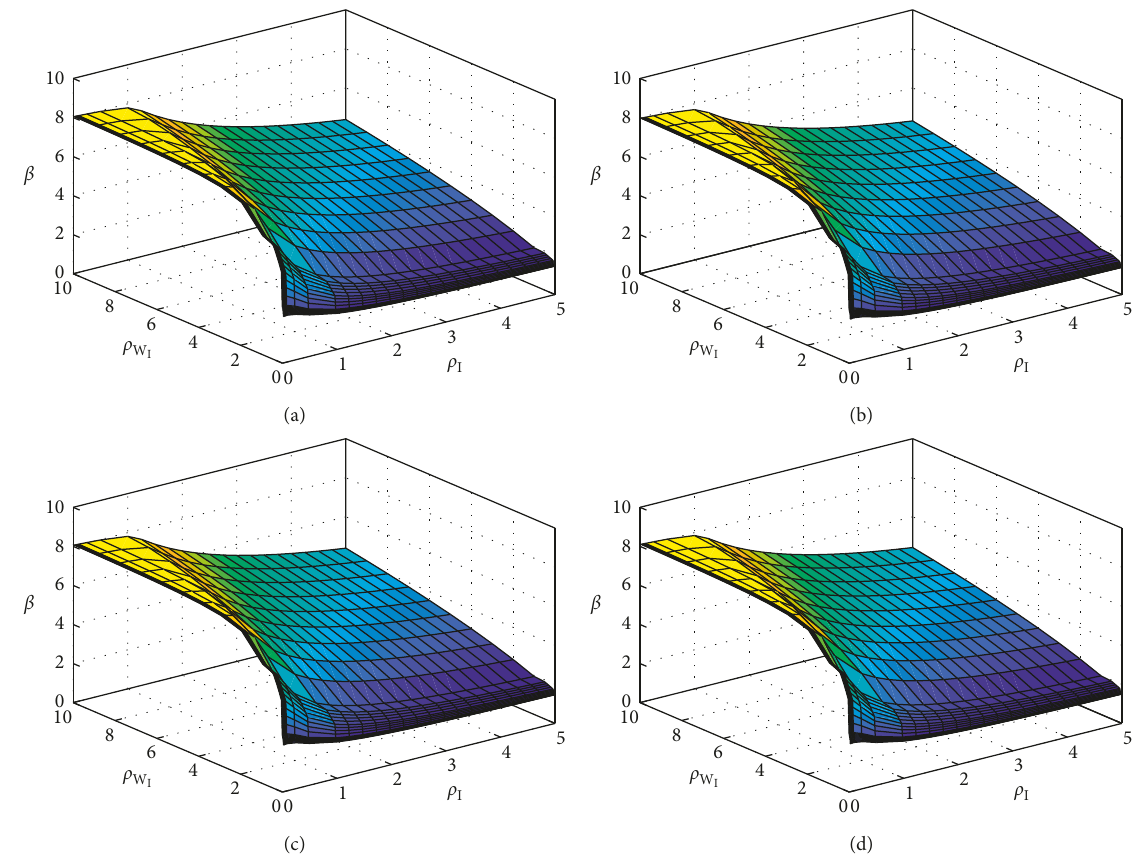
Figure 5: Reliability indices for stability calculation of axially loaded member. (a) Q235: d > 16 ∼ 40mm, (b) Q235: d > 40 ∼ 60 mm, (c) Q345: d > 16 ∼ 35 mm, and (d) Q345: d > 35 ∼ 50 mm. Table 8: Reliability indices of member of different steel classes.